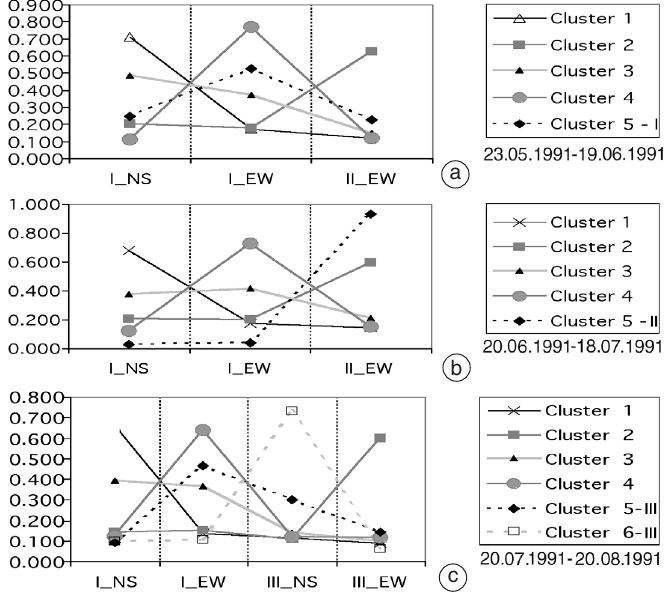
Fig. 4a-c. The distribution of relative amplitudes of signals at the points of measurement produced by the clus- ter centers of sources for the three independent intervals of monitoring. The Roman numbers designate the points of measurement. NS and EW specify directions of measuring